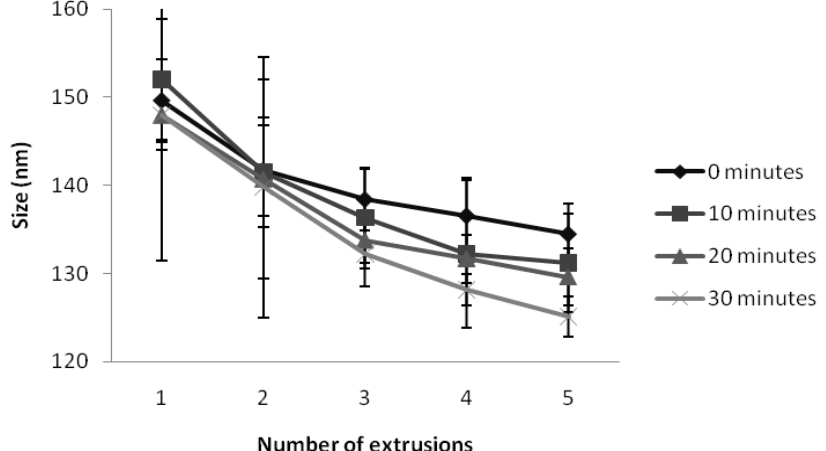
Figure 1. Influence of sonication time and number of extrusions on vesicle size.